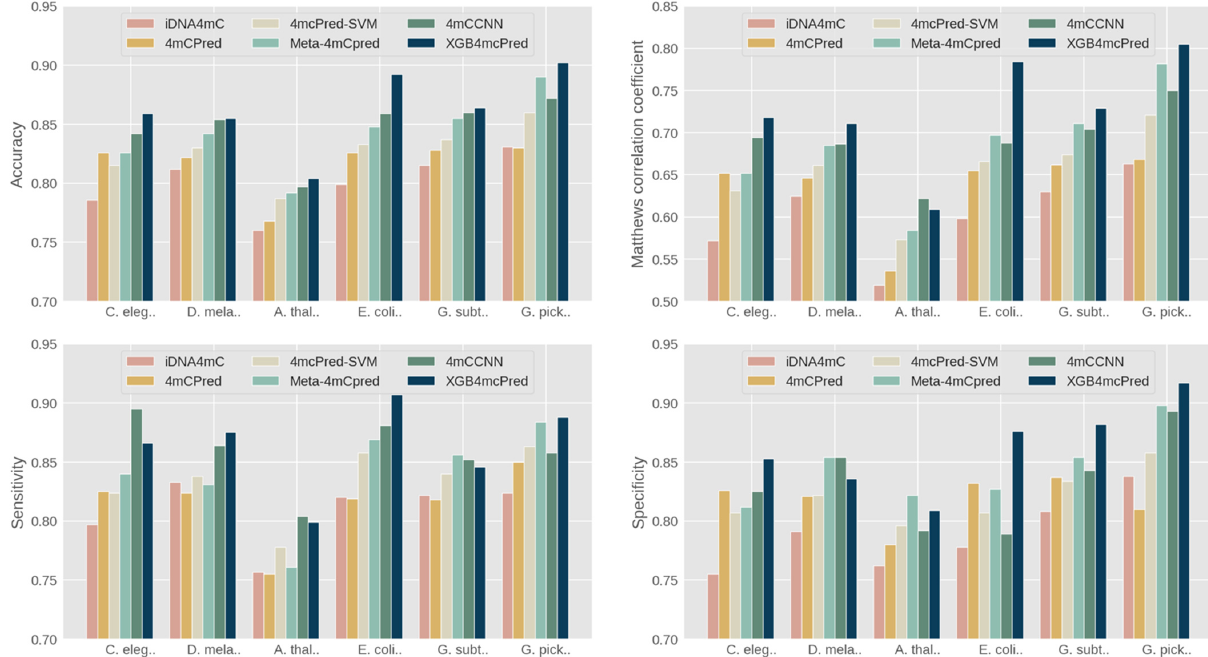
Figure 8. Performances of the proposed XGB4mcPred and five state-of-the-art predictors on six benchmark datasets from different species.